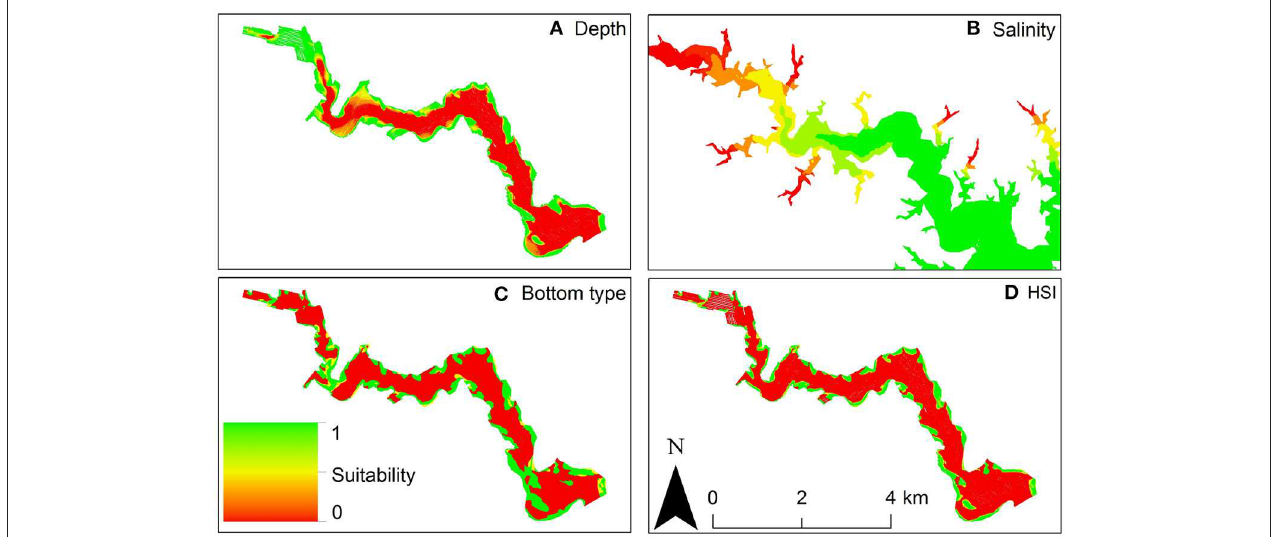
FIGURE 12 | Habitat Suitability Index model for eastern oyster Crassostrea virginica . (A) Depth suitability layer. (B) Salinity suitability layer. (C) Bottom type suitability layer. (D) Habitat suitability index output: red areas are unsuitable oyster habitat, green areas are optimal oyster habitat in the Great Wicomico River, a western shore tributary of lower Chesapeake Bay. Figure reproduced with permission (Creative Commons Attribution 4.0 International Public License) from Theuerkauf and Lipcius